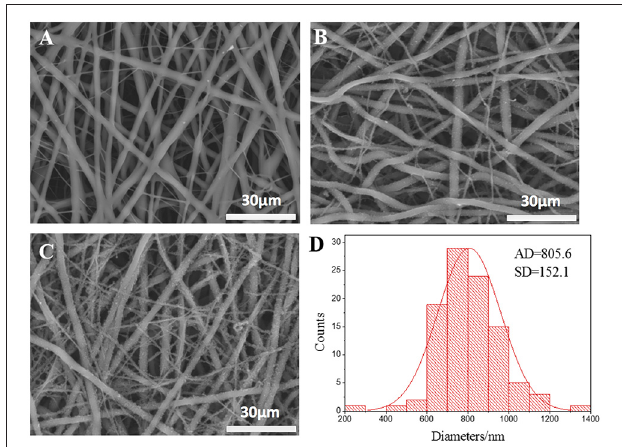
FIGURE 2 | The attenuated total reflection fourier transform infrared (ATR-FTIR) spectroscopy of PLCL nanofibers, PPY, PPY/PLCL-1 nanofibers (6 h) and PPY/PLCL-2 nanofibers (12